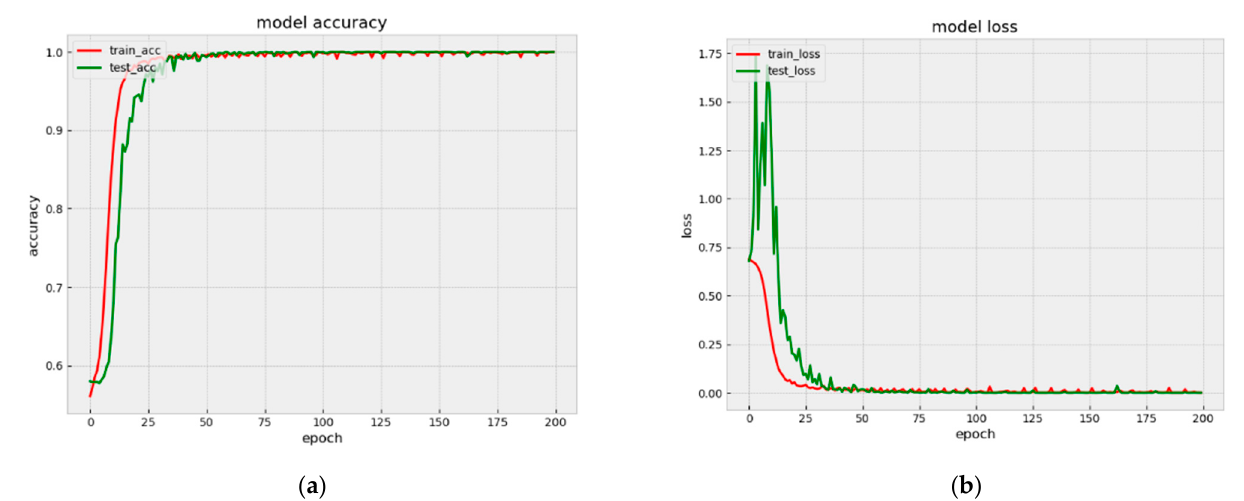
Figure 10. Model accuracy and loss curves ( a ) accuracy in Arousal, ( b ) loss in Arousal